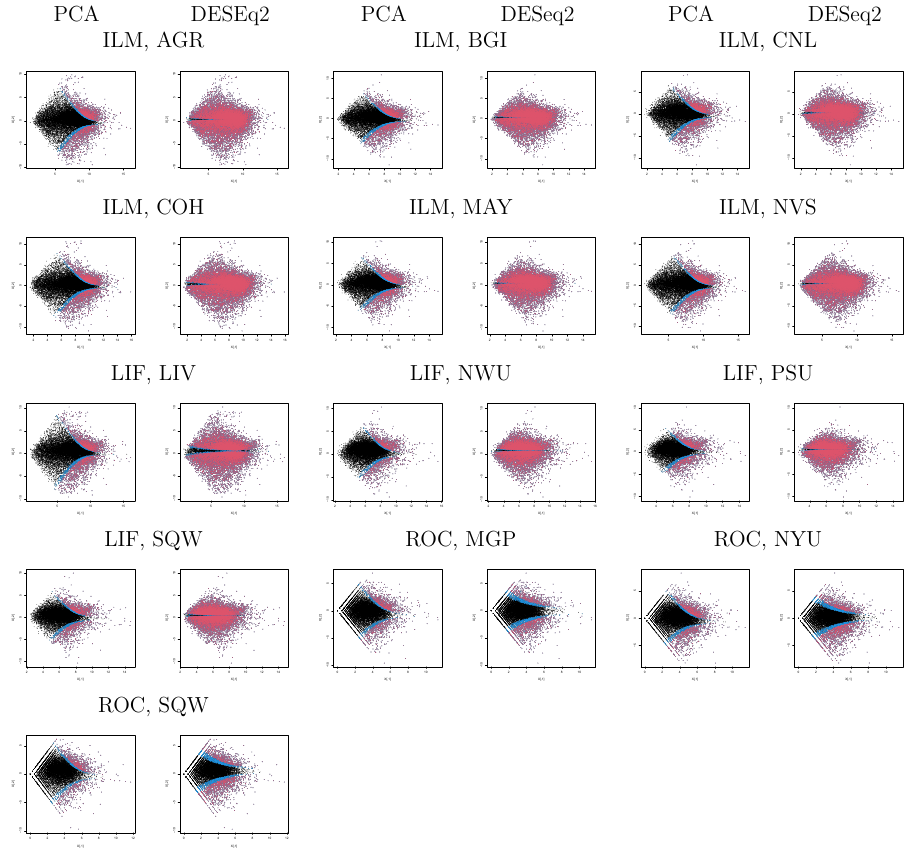
Figure 11. MAPlot for SEQC PCA-based unsupervised FE with optimized SD: the first, third, and fifth columns, DESeq2: the second, forth, and sixth columns. Three character IDs represent platform and sites. Blue: genes associated with adjusted P values less than 0.1 but greater than 0.01. Red: genes associated with adjusted P values less than